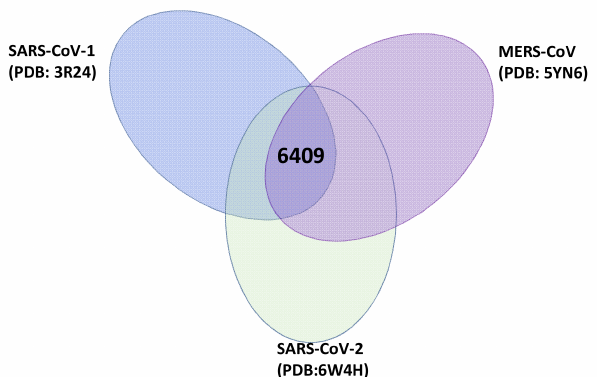
Figure 2. Venn diagram of top 30% ligands bound to SARS-CoV-2, SARS-CoV-1, and MERS-CoV nsp16s.